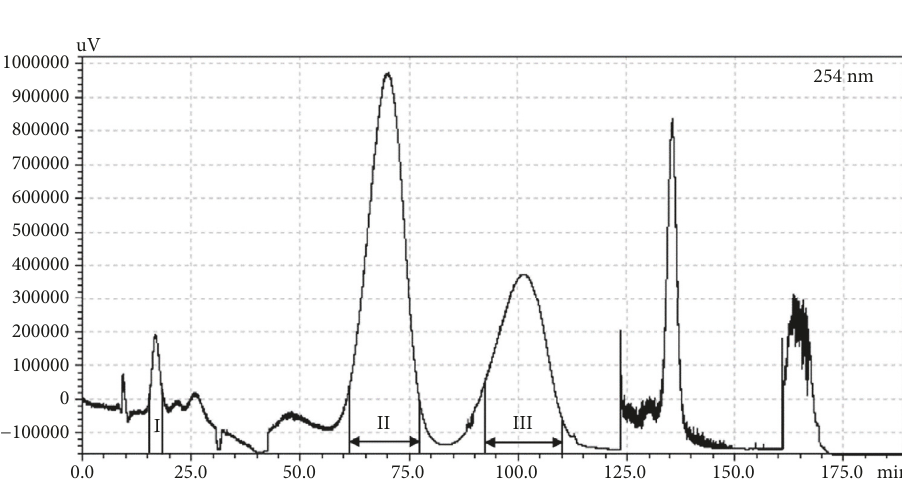
Figure 3: CPC separation of the SC-CO 2 extract of the leaves of P. frutescens var. crispa (cv. Antisperill) using n-hexane/ethyl acetate/ethanol/water(5:5:5:5,v/v) in a descending mode (for CPC conditions, see Section 2). The extrusion was performed after 115 min.